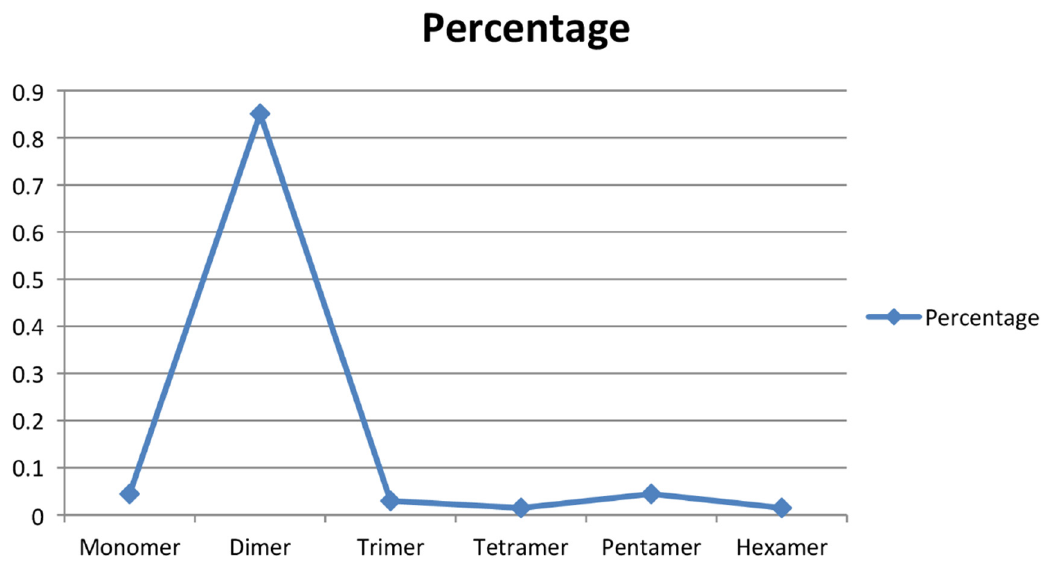
Figure 2. SSR motif-length groups and their percentage occurrence.